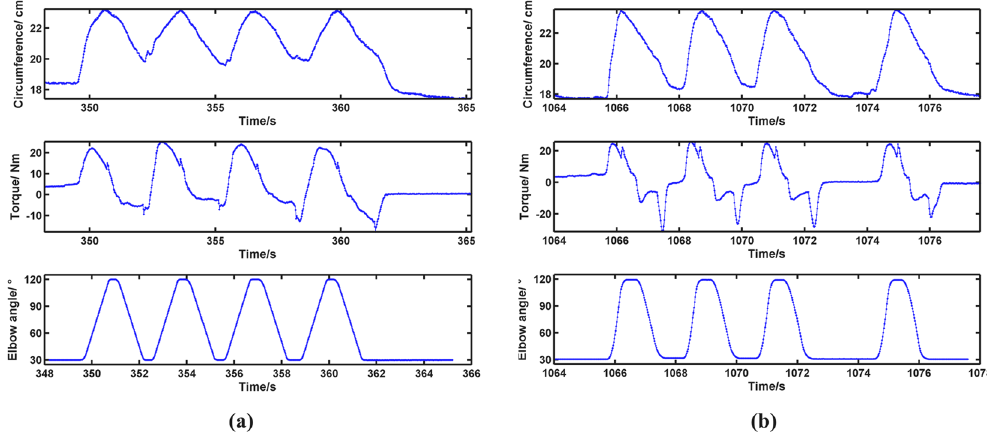
Figure 2. ( a ) Raw data of circumference, torque and elbow angle in isokinetic test (Subject No. 1’s 1 st isokinetic set at 90°/s). ( b ) Raw data of circumference, torque and elbow angle in isokinetic test (Subject No. 1’s 1 st isotonic set at 30% T 120